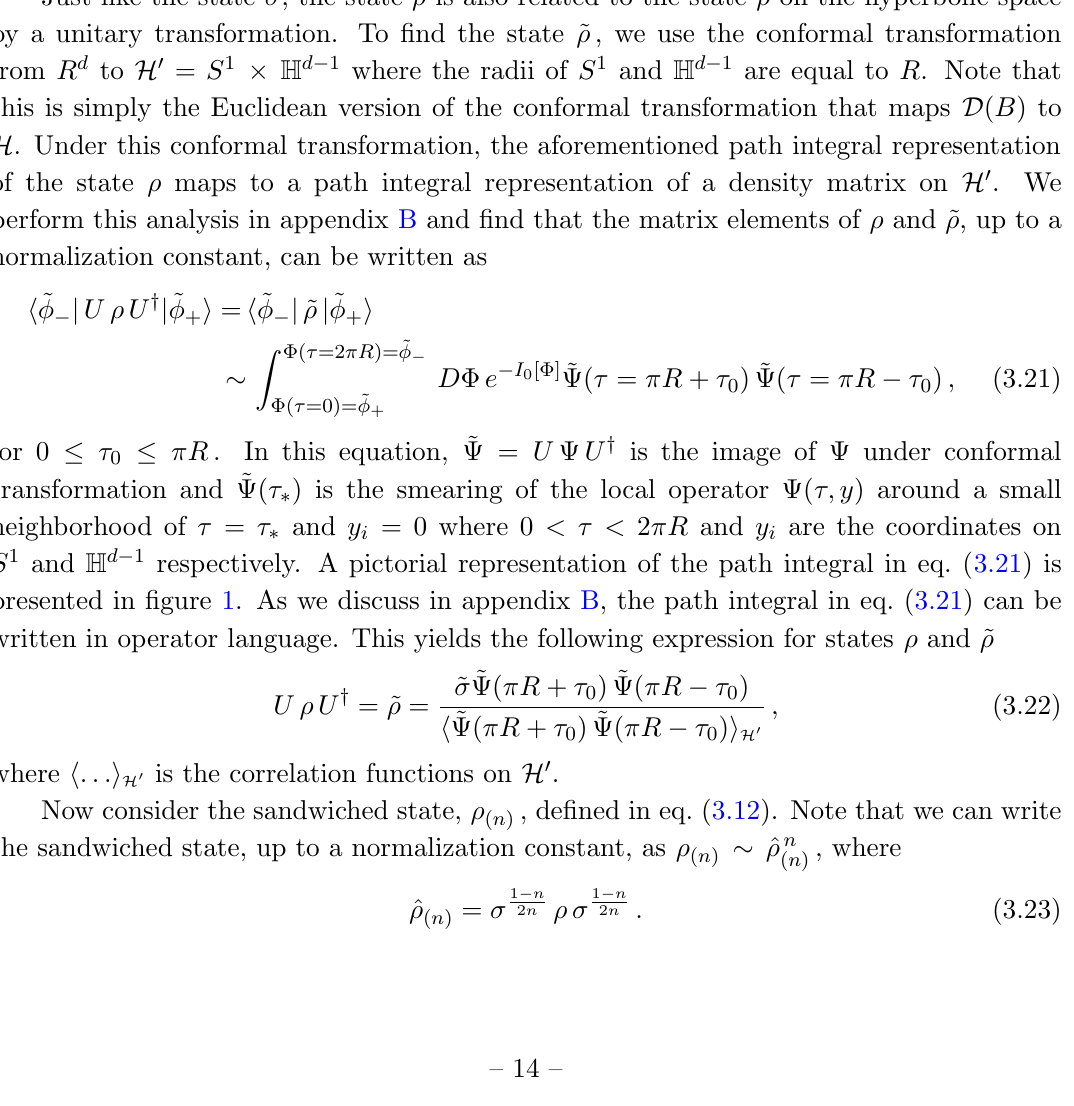
Figure 1 . The pictorial representation of the construction of the states (cid:26) and (cid:26) H d (cid:0) 1 . The vertical direction denotes the direction along the S 1 whereas 0 = S 1 path integral over H (cid:2) the horizontal direction denotes the radial direction of H d (cid:0) 1 and we have suppressed the transverse d 2 dimensions. (This (cid:12)gure is inspired by (cid:12)gure 1 of (cid:0)